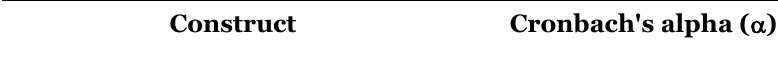
Cronbach's Alpha Coefficients for Construct Reliability Measurement